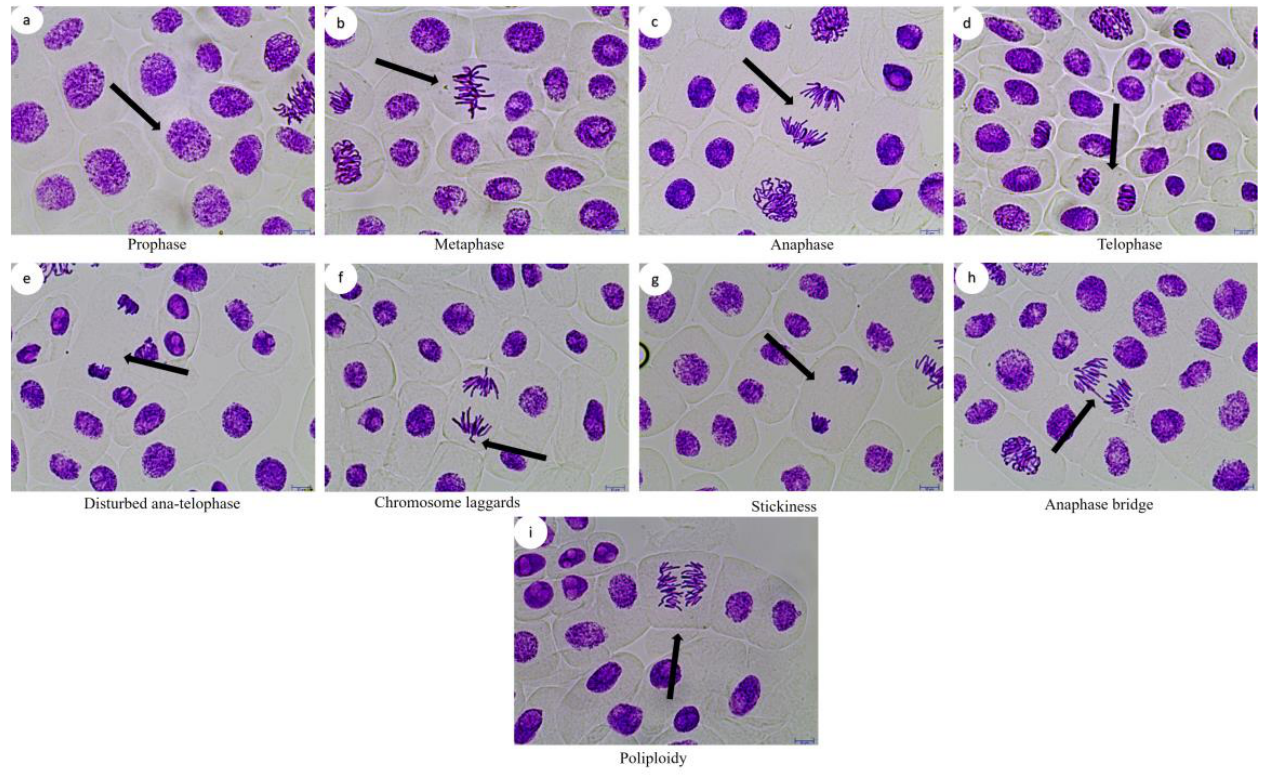
Figure 3. Typical stages of mitosis ( a – d ) and ana-telophase anomalies ( e – i ) induced by FLB in A. cepa cells. Scale bars: 10 µm.